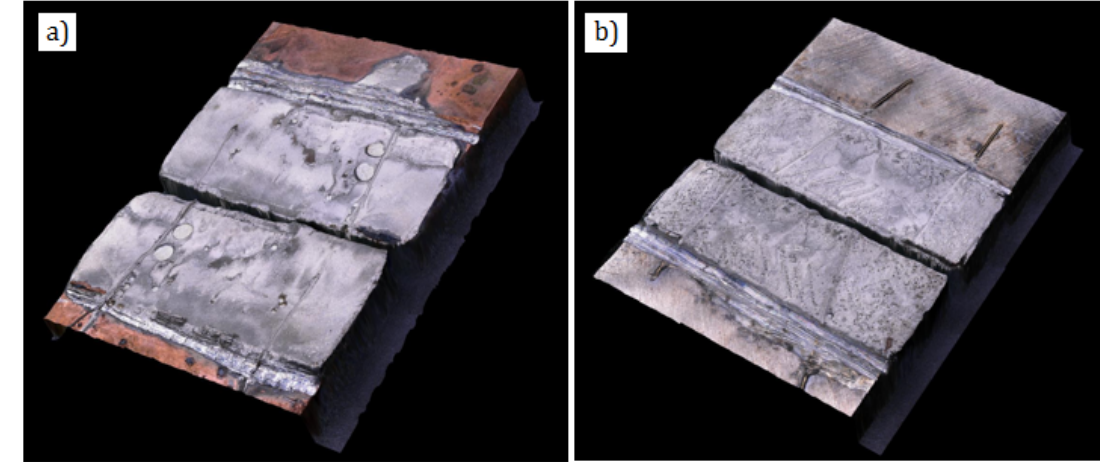
Figure 9. Cohesive fractures within solder after shear strength test: joints soldered with Cu-Cr ( a ) and Ni-P ( b ) interlayer.